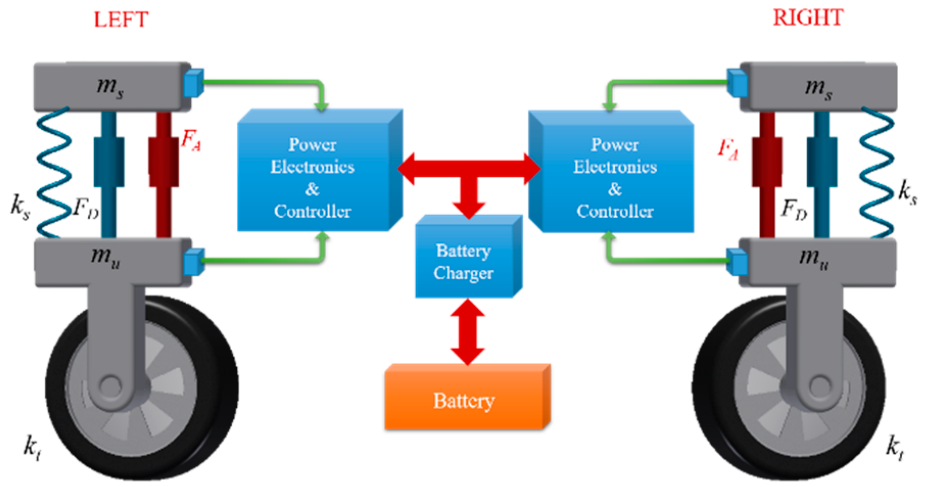
Figure 1. Configuration of energy-harvesting suspension.